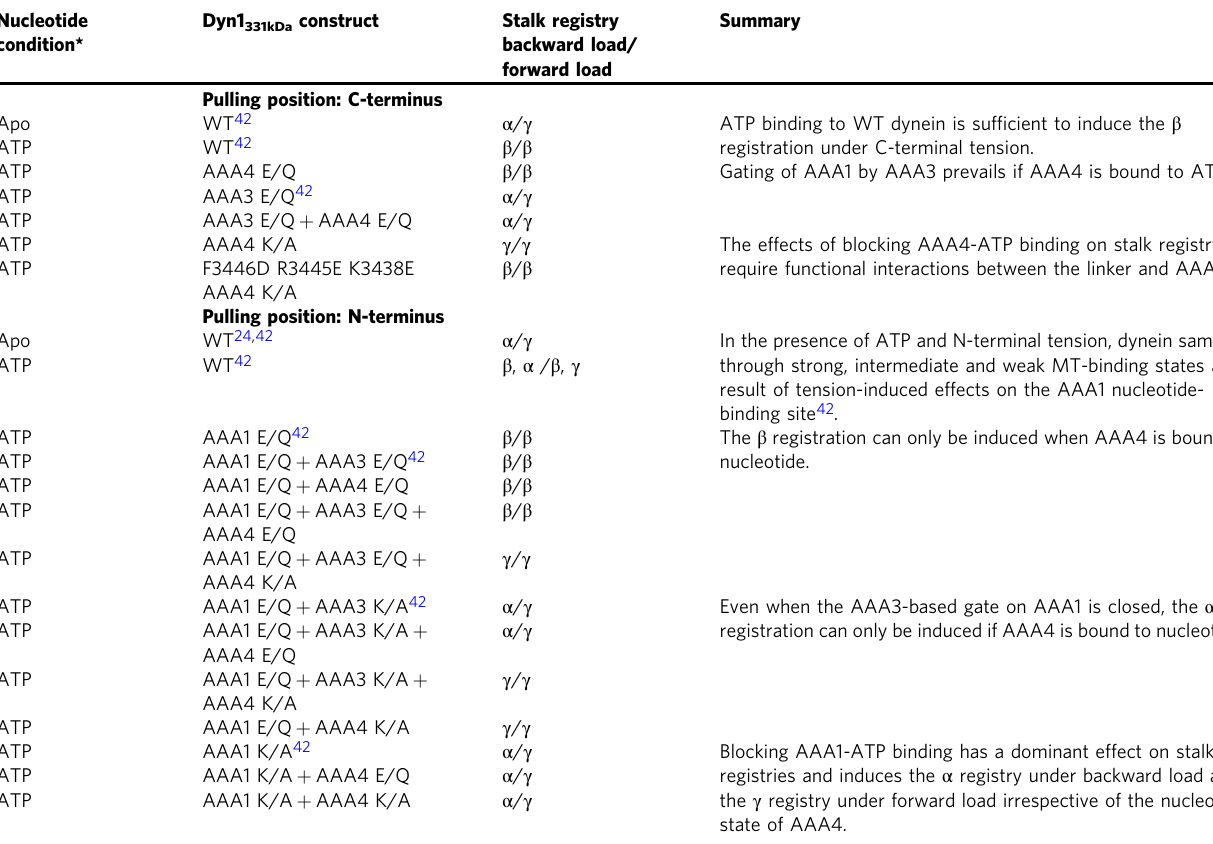
Table 1 Relation of nucleotide condition, pulling position, AAA + ATPase mutations and stalk-helix registrations. Nucleotide